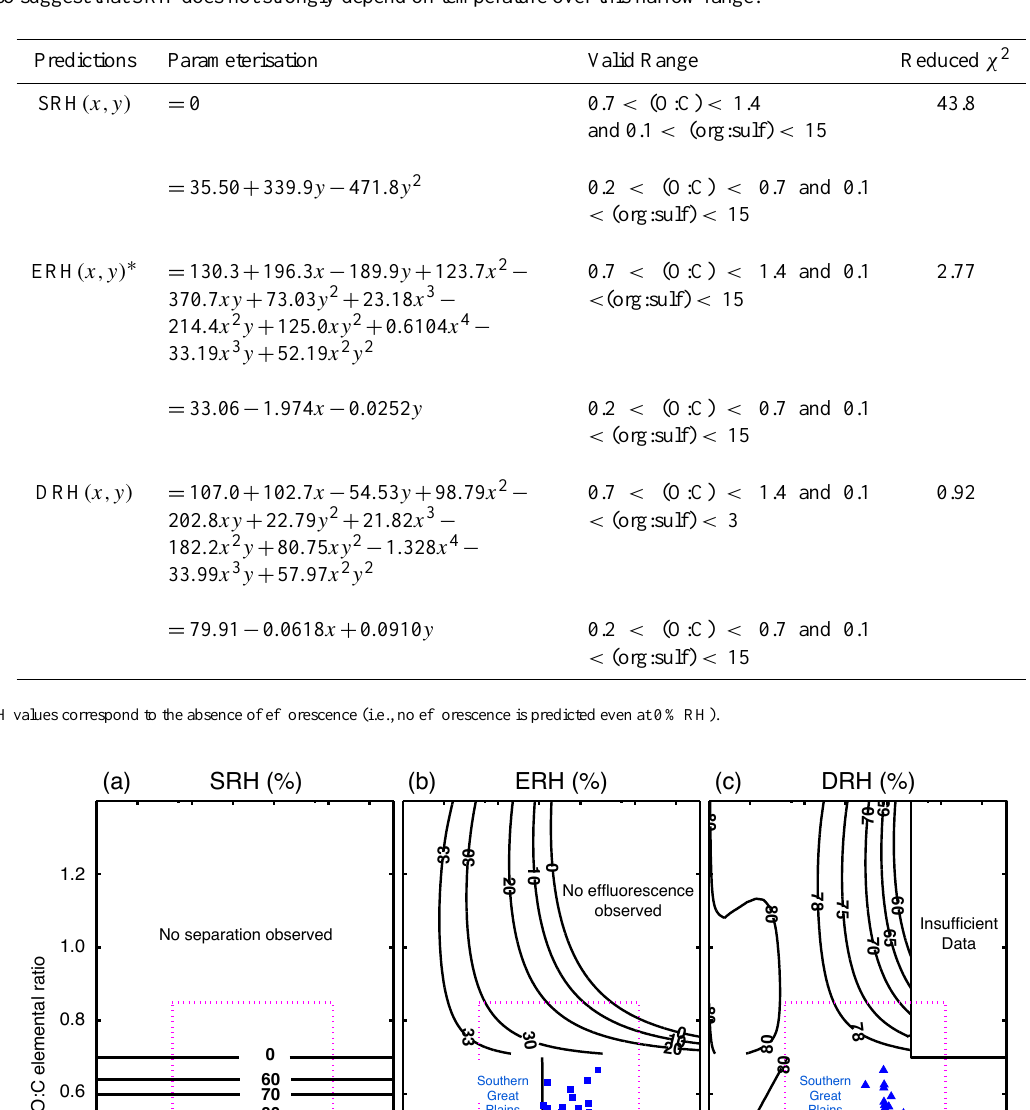
Table 2. Parameterisations of the SRH, ERH, and DRH data. In the parameterisations, terms include x = log 10 (org:sulf mass ratio) and y = O:C atomic ratio. Data used to develop the parameterizations were recorded at temperatures ranging from 290 to 298 K. Over this temperature range ERH and DRH do not strongly depend on temperature. Initial work with trihydroxyhexane and ammonium sulfate mixtures also suggest that SRH does not strongly depend on temperature over this narrow range.